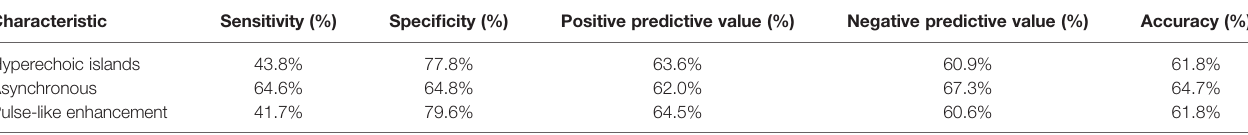
TABLE 3 | Diagnostic accuracy of US and CEUS for tuberculous lymphadenitis and lymph node metastasis. Characteristic Hyperechoic